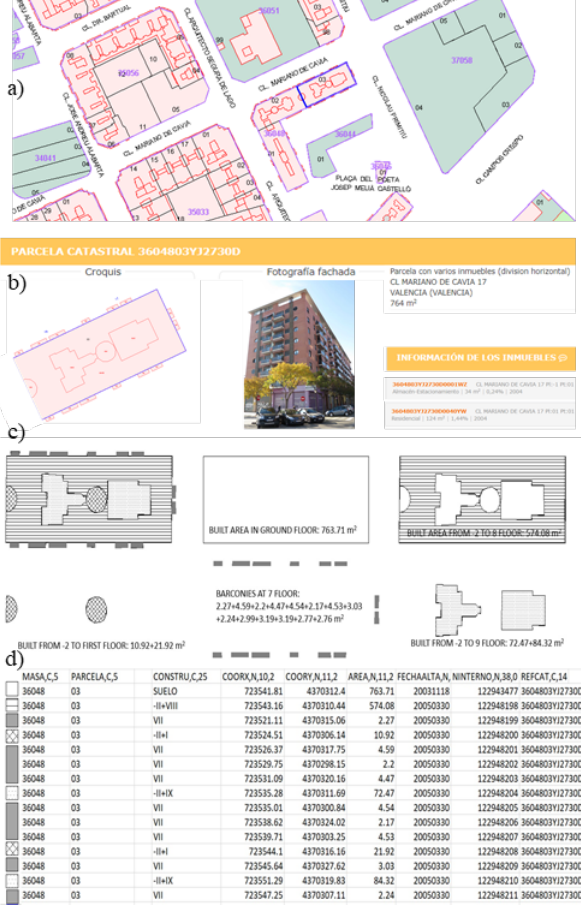
Figure 4. Aggregate building position; a) middle, b) corner, Figure 5. Cadastral Database: a) cadastral map, b) building